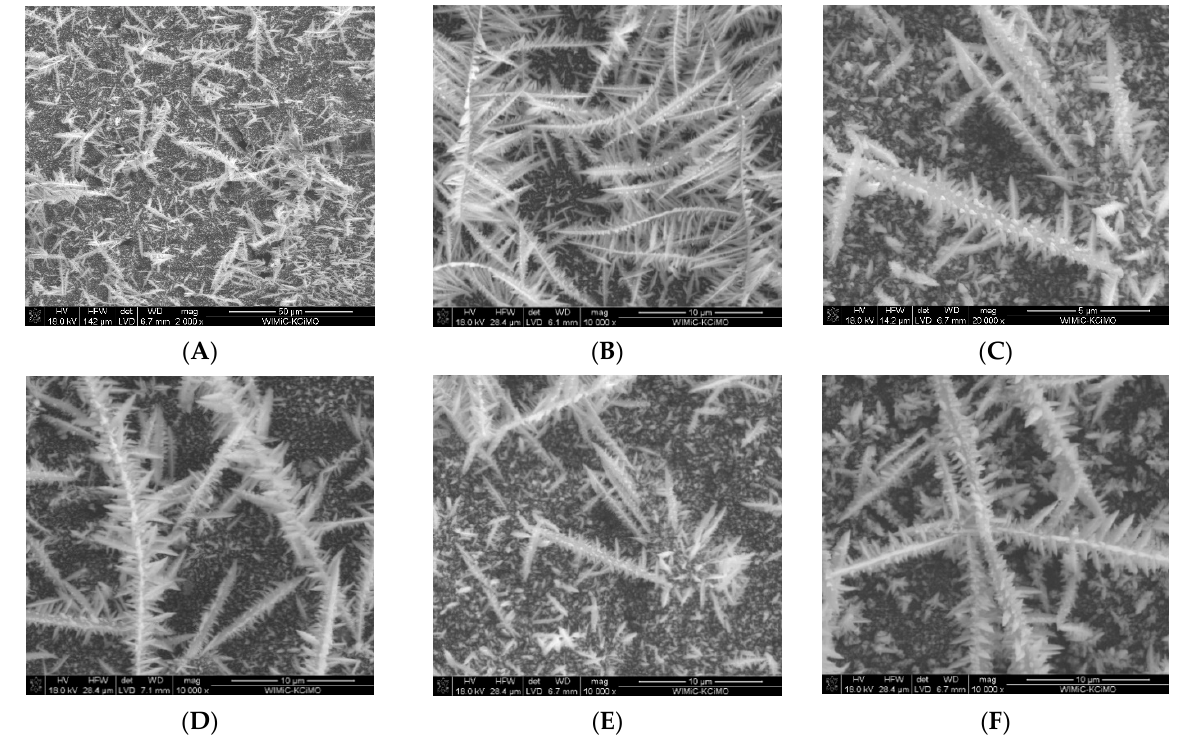
Figure 3. SEM images of bismuth layers deposited on GC ( A – C ) and screen-printed supports: carbon ( D ), mesoporous carbon ( E ), and ordered mesoporous carbon ( F ). Plating parameters: solution 43 mM Bi(III) in 0.34 M HClO 4 , plating potential − 0.9 V, plating charge 7 mC per mm 2 of the support surface.